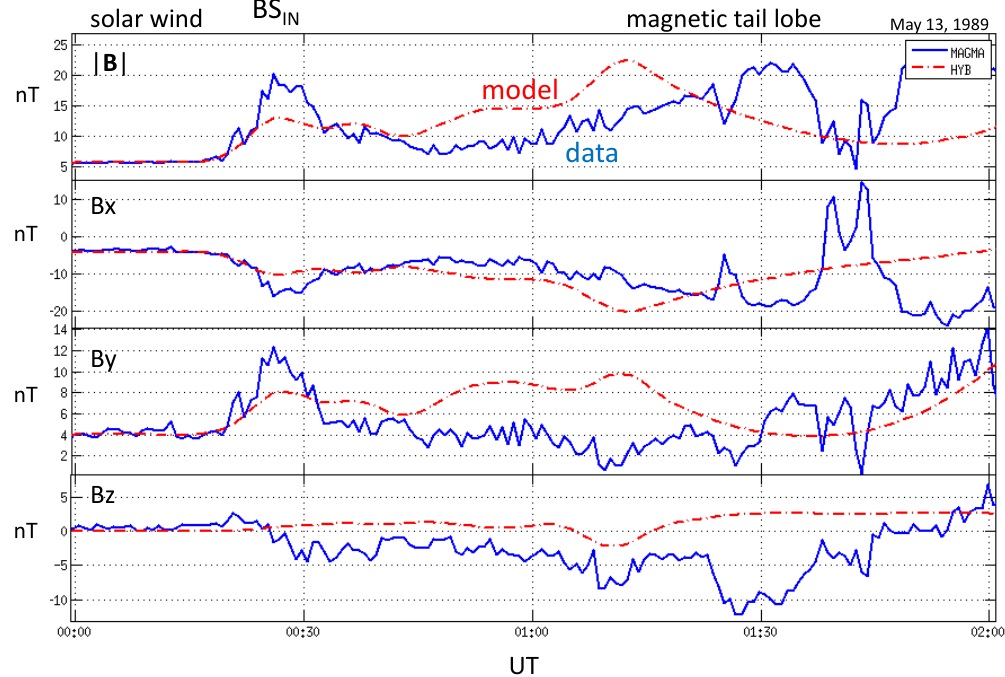
Fig. 5. Comparison of the magnetic field modelled by the HYB-Mars simulation (dashed/dotted lines) and the magnetic field (solid lines) measured by MAGMA/Phobos-2 on 13 March 1989. Phobos-2 was initially in the solar wind, then crossed the bow shock (BS IN ) and entered the magnetic tail